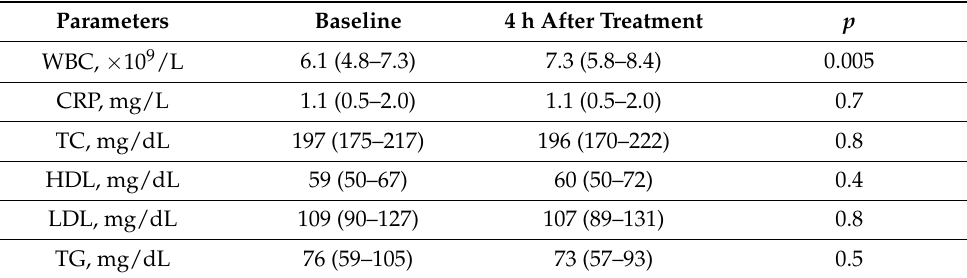
Table 2. Inflammatory and biochemical parameters in the study